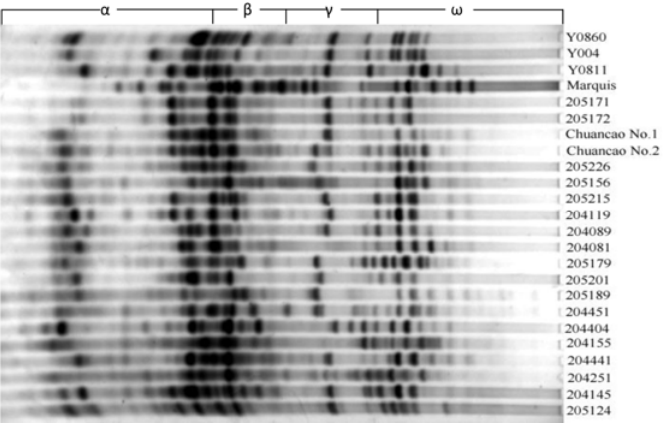
Figure 1. Gliadin patterns of parts of accessions of Elymus sibiricus after acid polyacrylamide gel electrophoresis (A-PAGE). The places of α , β , γ and ω -gliadins are indicated.